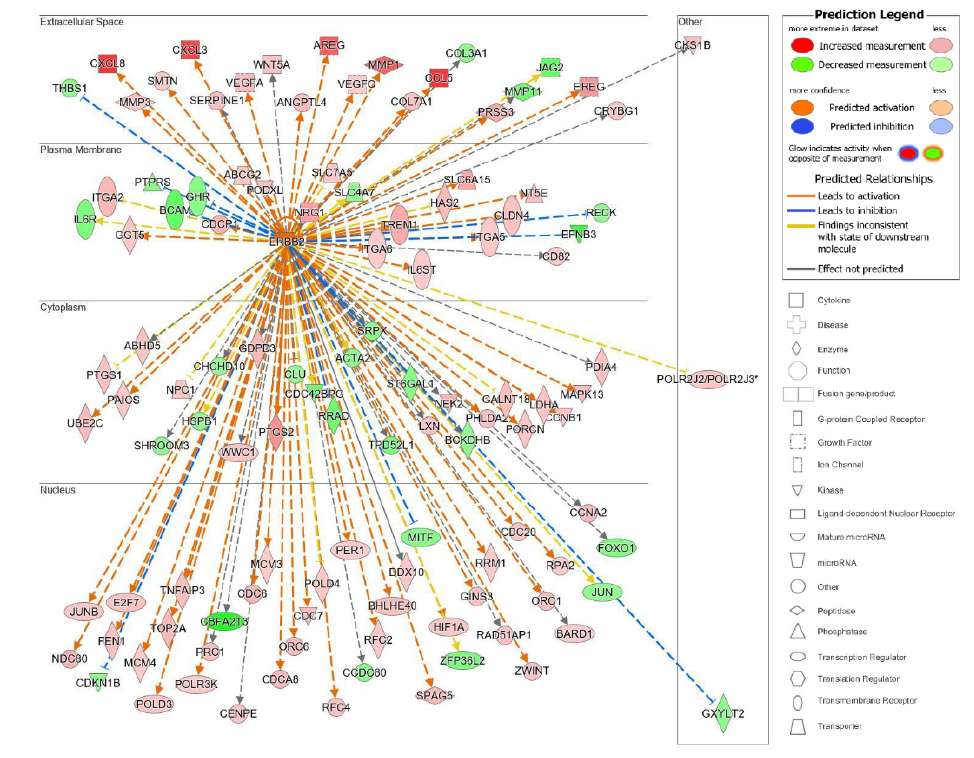
Figure 7. Top upstream regulator ErbB2. ErbB2 and the downstream targets in our dataset are displayed with their subcellular location. The upstream regulator analysis (URA) tool was used in IPA to identify the top upstream regulators that based on available literature could be responsible for driving expression changes seen in our dataset and that met criteria for p < 0.05. The top upstream regulator based on p -value of overlap was epidermal growth factor receptor 2 (ErbB2, p = 3.28 × 10 − 16 ). * indicates multiple identifiers in the dataset file map to a single gene in the Global Molecular Network.